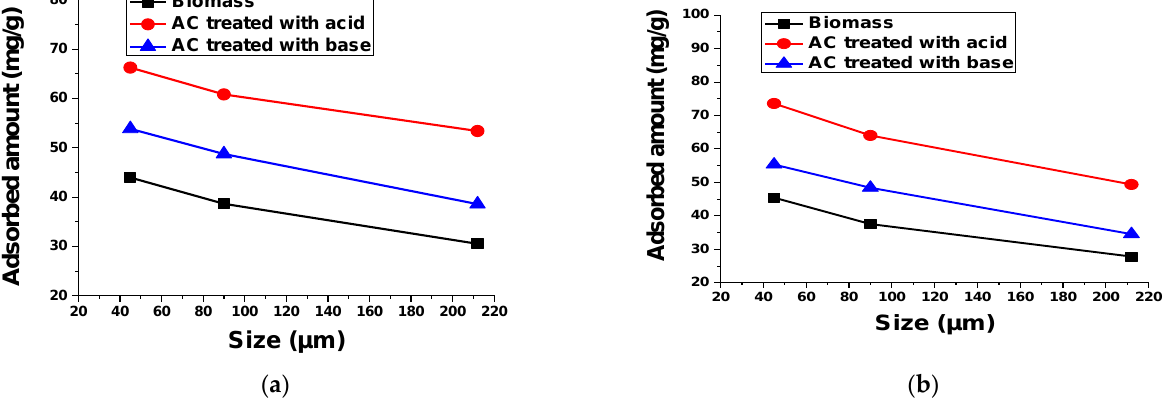
Figure 15. Effect of particle size for 0.1 g biomass and AC treated with acid and base on the adsorption of 50 mL ( a ) 100 mg/L TB and ( b ) 50 mg/L XO for 60 min at 140 rpm and room temperature.